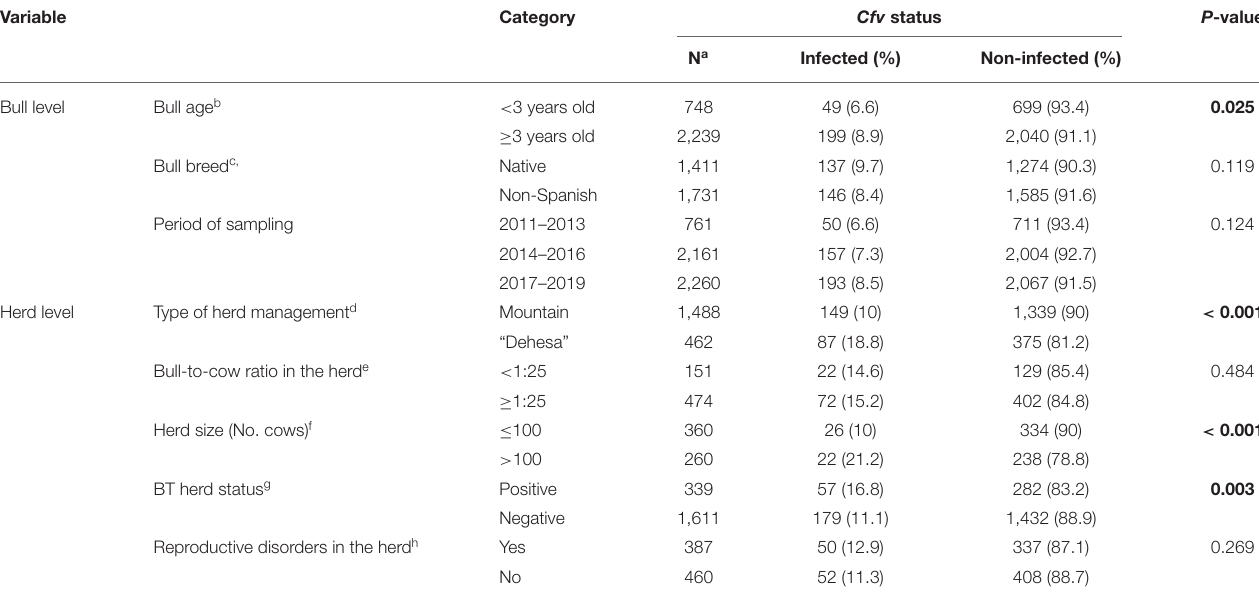
TABLE 2 | Results of the bivariate analysis of potential risk factors associated with Campylobacter fetus subsp. venerealis infection in breeding bulls and extensive beef cattle herds in Spain. Variable